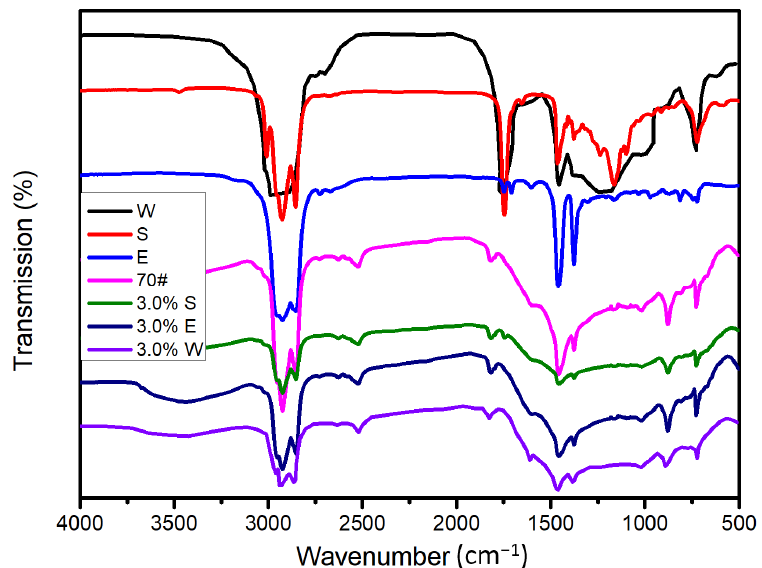
Figure 1. Fourier-transform infrared spectroscopy (FTIR) spectra of the asphalt and studied healing agents (sunflower oil (S), engine oil (E), waste cooking oil (W)).